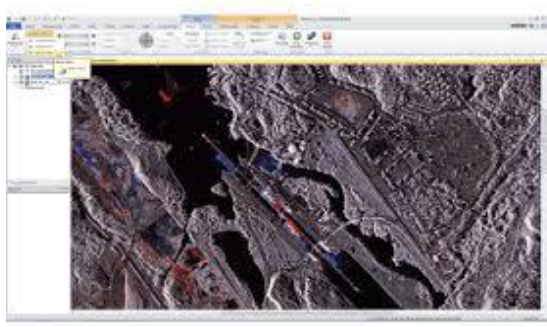
Fig 6. A Snapshot of